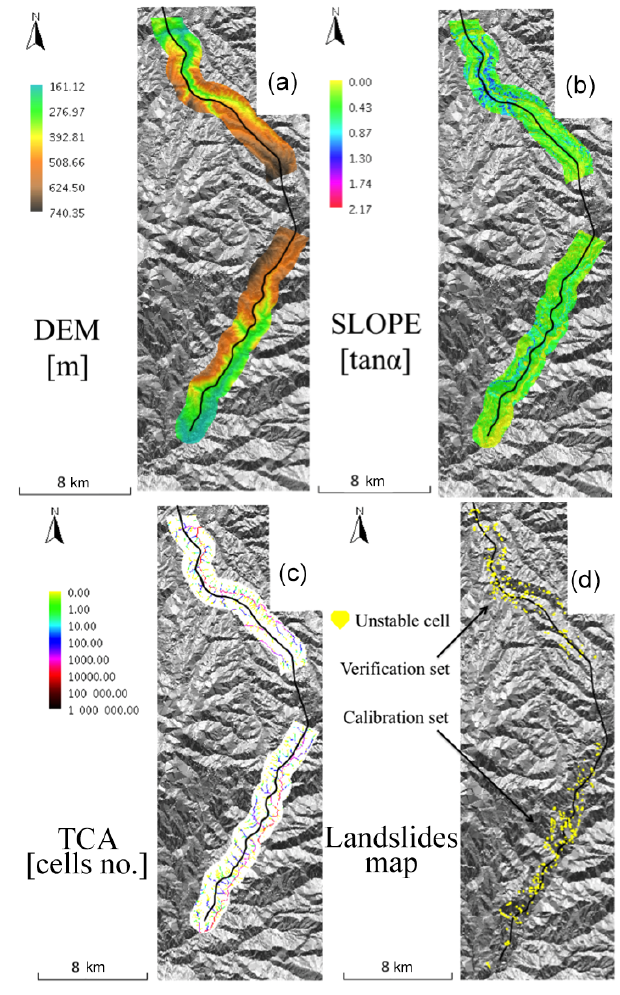
Figure 2. Test site. (a) Digital elevation model (DEM) (m), (b) slope (–) expressed as tangent of the angle, (c) total contributing area (TCA) expressed as number of draining cells, and (d) map of actual